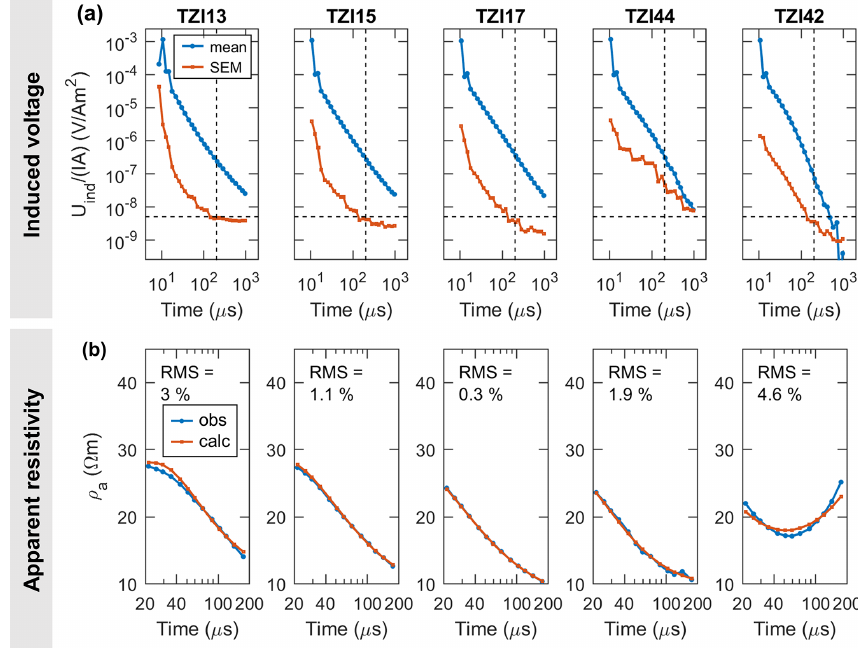
Figure A1. (a) Induced-voltage data of selected TEM soundings along Profile 6 of Lake Tzibaná. Induced voltages are normalized with the injected current and the loop area. The mean values of the stacked signal per time gate are shown in blue (circles), the standard error of the mean in red (squares). Dashed lines indicate an almost constant (exception: sounding TZI44) late-time error level of 5 × 10 − 9 VAm − 2 (horizontal lines) at 174.5µs (vertical lines). (b) Observed (blue circles) and calculated (red squares) apparent resistivity curves of the same TEM soundings. The root-mean-square (RMS) errors of the individual model fits are indicated, too. The corresponding inverted models (smooth models with 20 layers) are visualized in Fig.